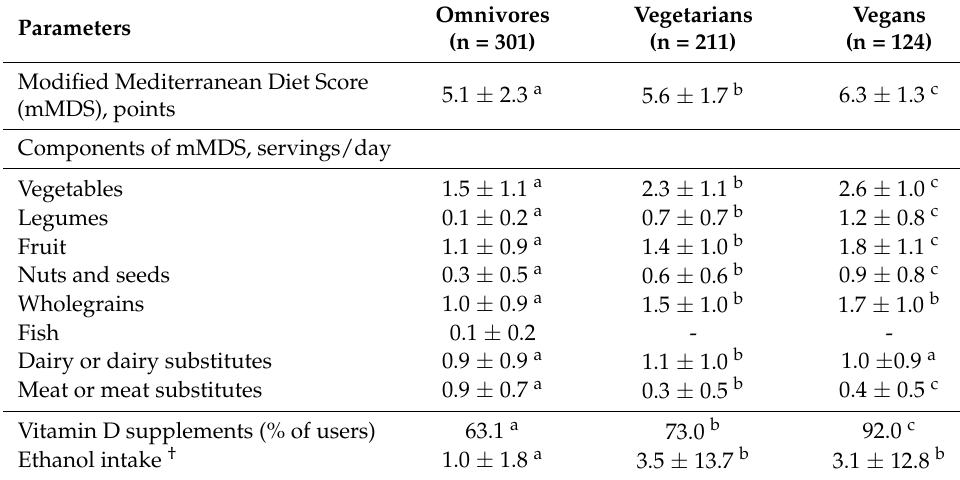
Table 2. Daily consumption of food groups by type of diet followed (mean ± SD).